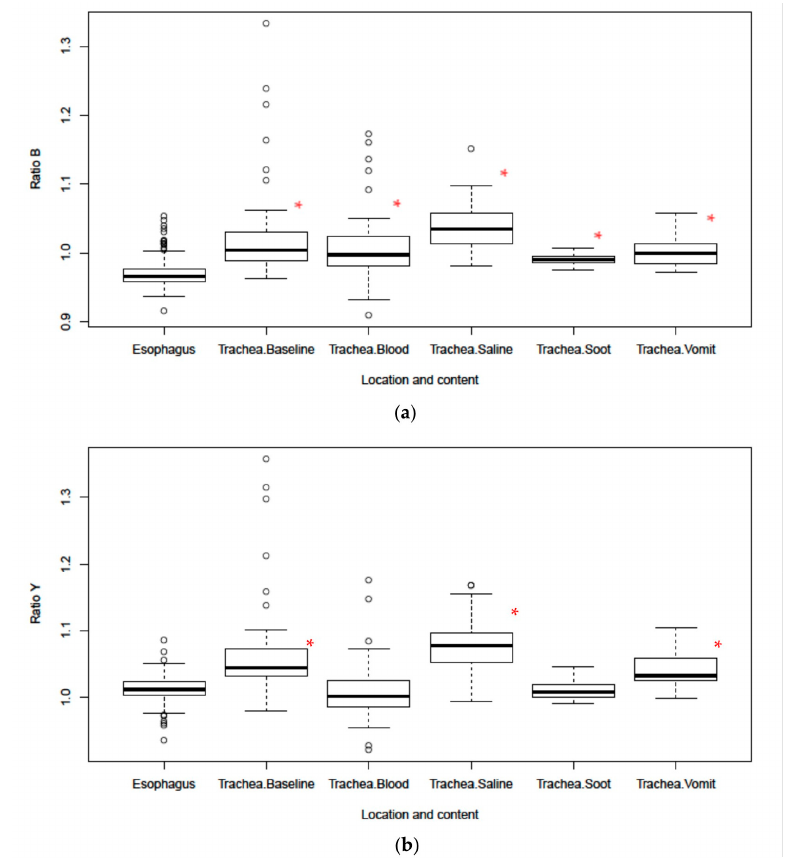
Figure 4. ( a ) Boxplot of Ratio B and ( b ) Ratio Y for tracheal and esophageal tissues in the presence of body fluids and soot. Dots in the boxplots are outliers, defined as being 1.5 times the interquartile range beyond the first or third quartiles. * Represents statistical significance vs. esophagus.